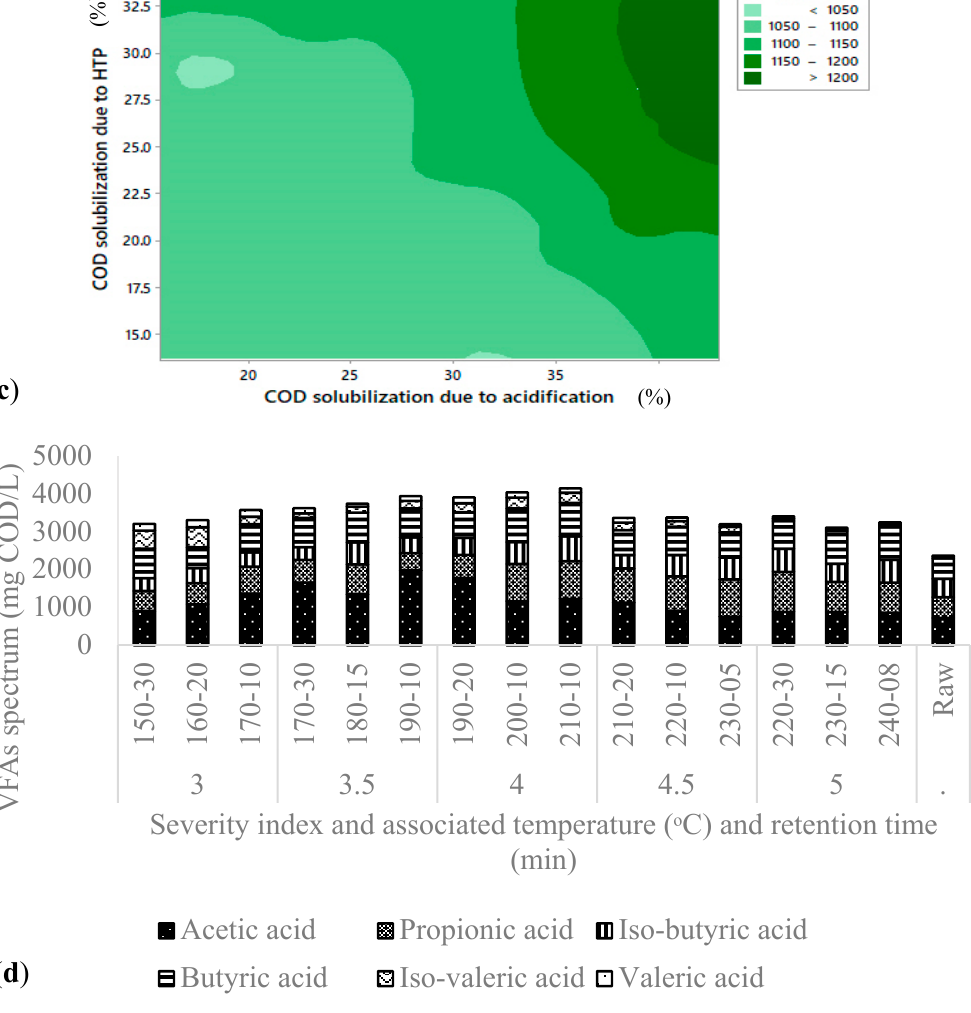
Figure 6. Volatile fatty acid (VFA) production after acidification ( a ) VFAs yield after acidification; ( b ) VFAs/SCOD ratio; ( c ) The contour plot of total VFAs vs. COD solubilization after hydrothermal pretreatment and acidification; ( d ) VFAs production spectrum.